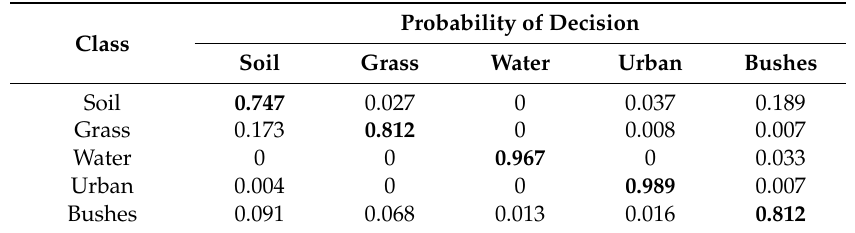
Table 14. Classification probabilities for the MLM method trained for the original image and applied to it.